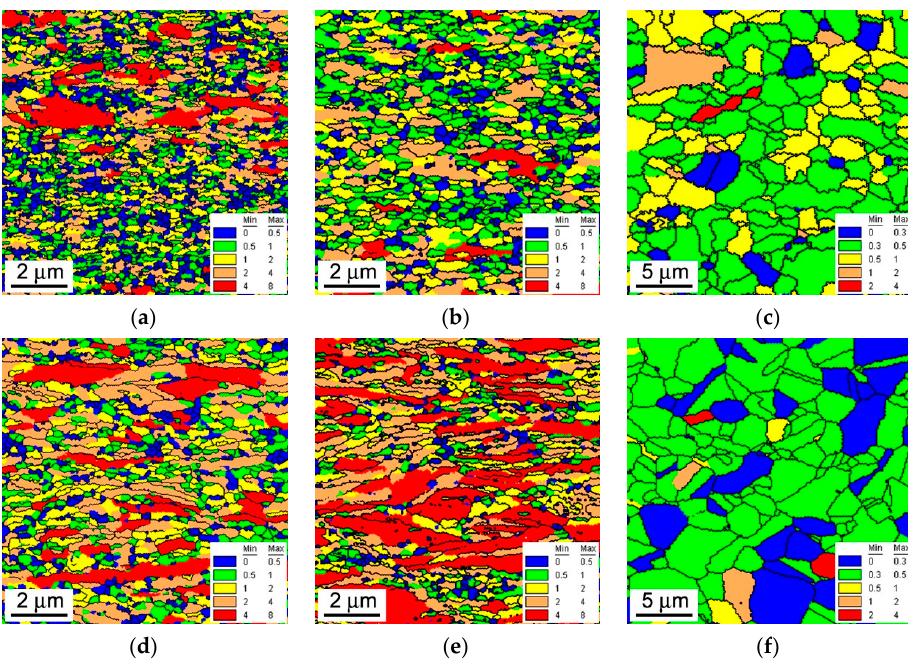
Figure 2. The grain orientation spread (indicated in degrees) in a 316L-type stainless steel subjected to cold rolling ( a, b, c ) or warm rolling ( d, e, f ) and subsequent annealing for 30 min at 873 K ( a, d ), 973 K ( b, e ) and 1073 K ( c, f ). The high-angle boundaries are indicated by black lines.